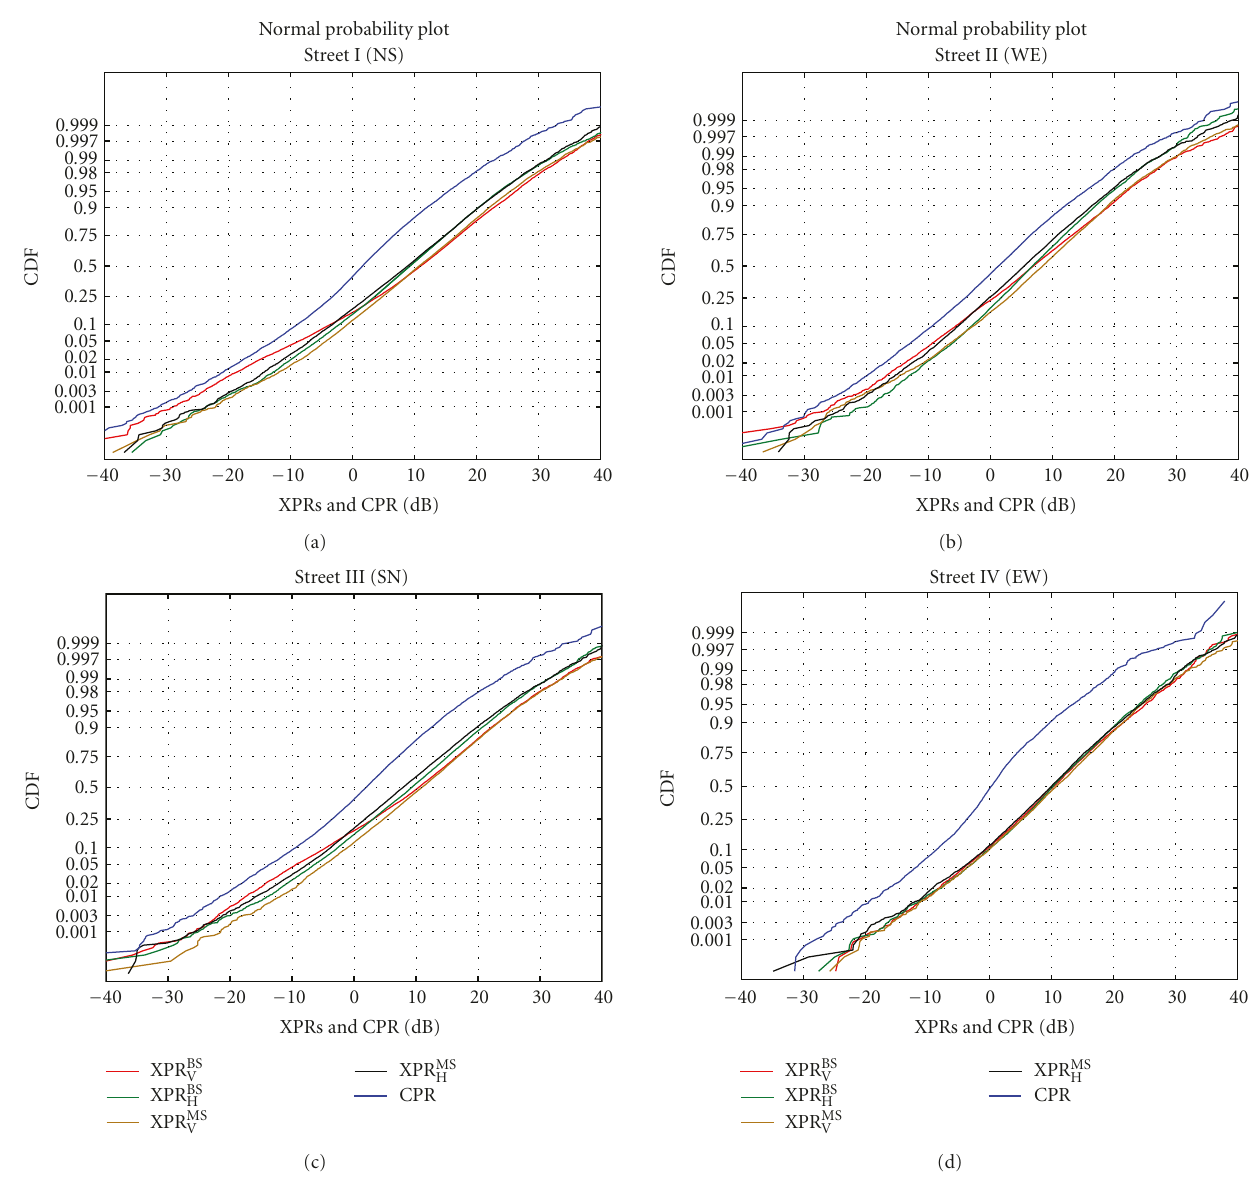
Figure 3: XPRs and